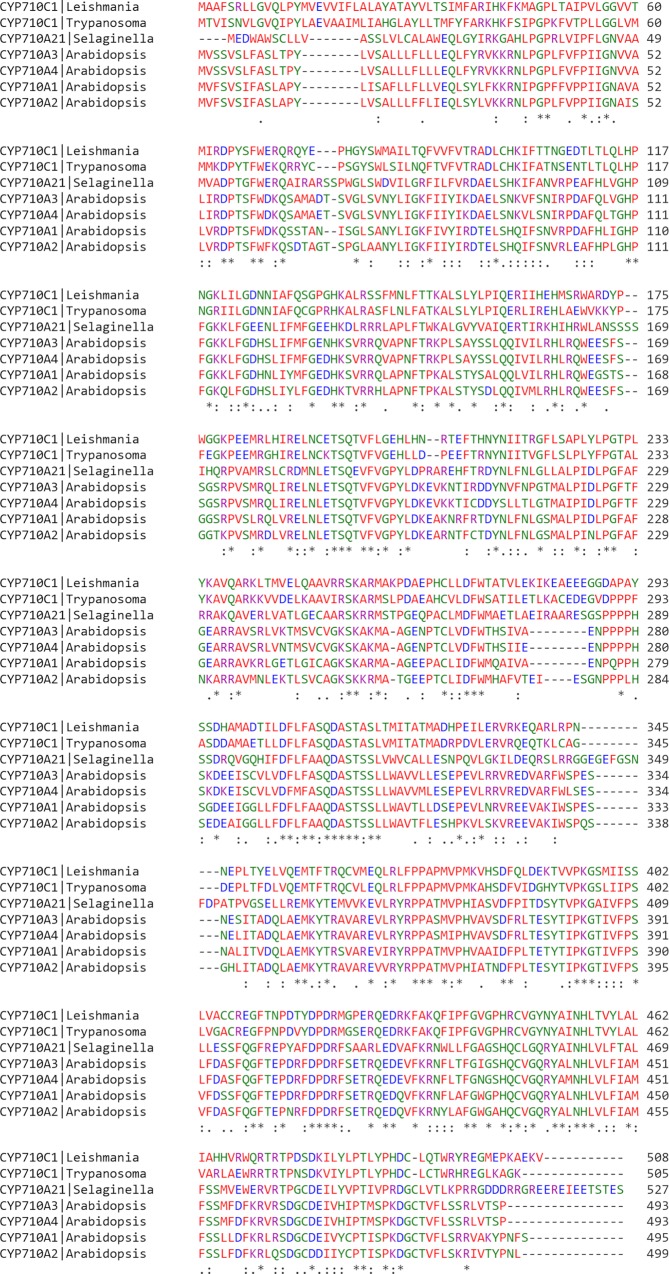
Multiple sequence alignment of CYP710 proteins using Clustal Omega (http://www.ebi.ac.uk/Tools/msa/clustalo/).For analysis, we used the following sequences: Leishmania donovani (LdBPK_303610.1), Trypanosoma cruzi (TcCLB.510101.50), Selaginella moellendorffii (Uniprot ID: D8QPW3) and Arabidopsis thaliana CYP710A1 (Uniprot ID: O64697), Arabidopsis thaliana CYP710A2 (Uniprot ID: O64698), Arabidopsis thaliana CYP710A3 (Uniprot ID:A0A178VR86), Arabidopsis thaliana CYP710A4 (A0A178VVZ9). Residues conserved in all five proteins are indicated by an asterisk. Residues having similar, or very similar physiochemical character is indicated by a dot or colon, respectively. The four conserved motifs are highlighted by a rectangular box.